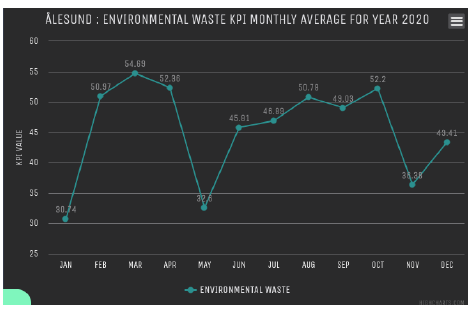
Figure 6. Monthly evolution of environmental waste in ˚Alesund, 2020.